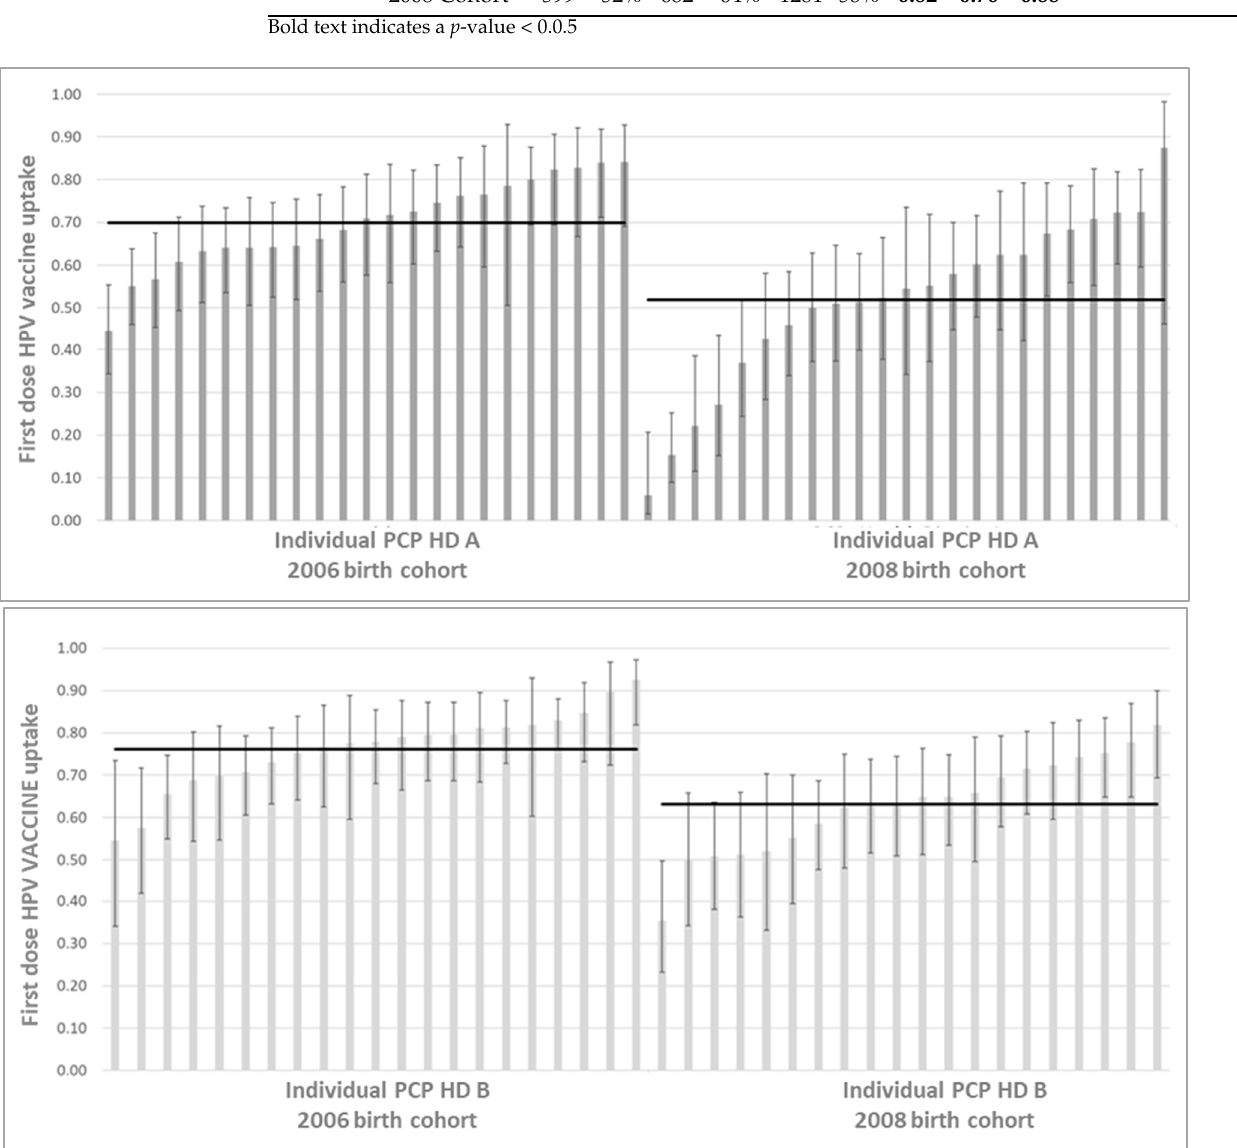
Figure 1. First dose of HPV vaccine among 12-year-olds in 2006 and 2008 birth cohorts, assisted by primary care pediatricians (PCPs). Health Districts (HD) of Local Health Unit 7, Veneto Region. Whiskers: 95% confidence interval for the estimated mean.